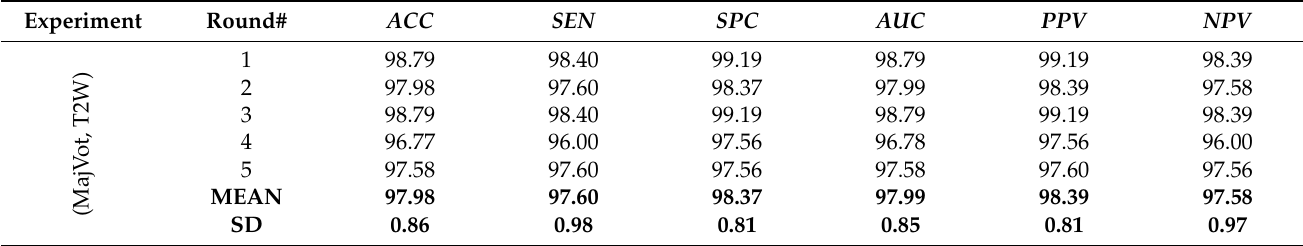
Table A14. Test results of five-folds of the experiment (MajVot,